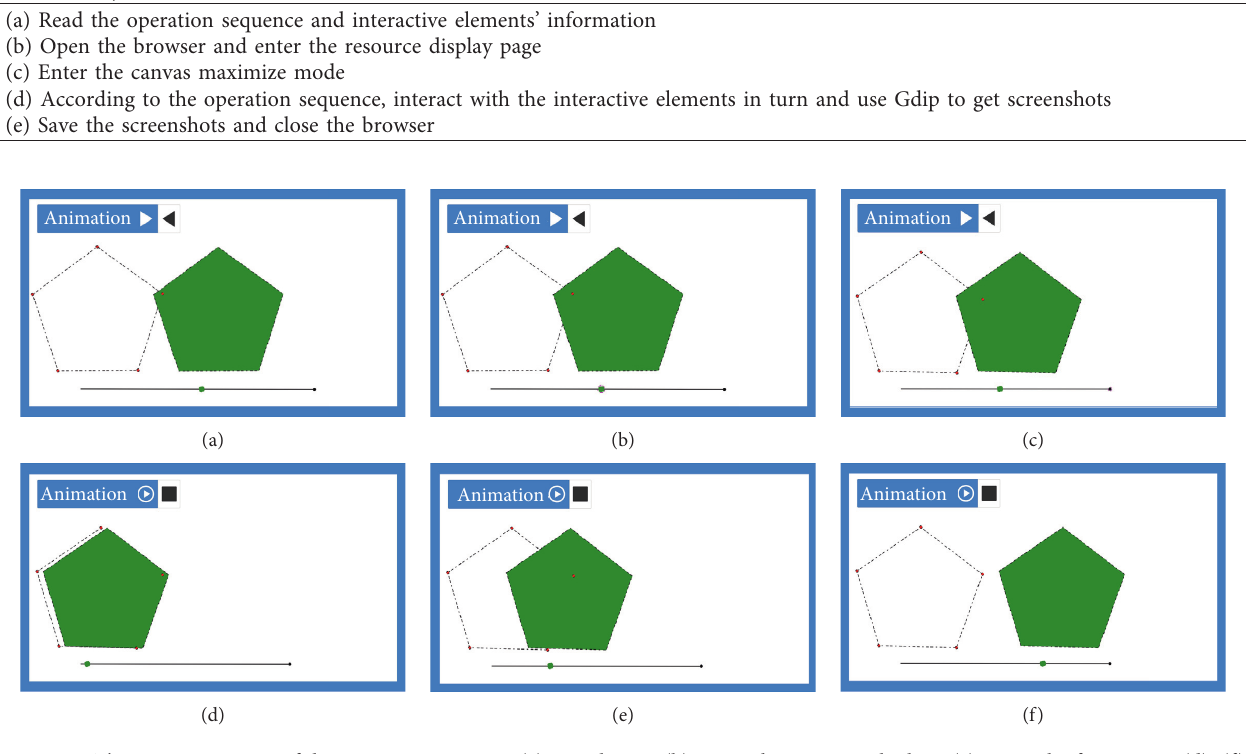
Figure 3: The picture preview of the interactive process. (a) Initial state. (b) Move the point on the line. (c) Move the free points. (d)–(f) Click the animation